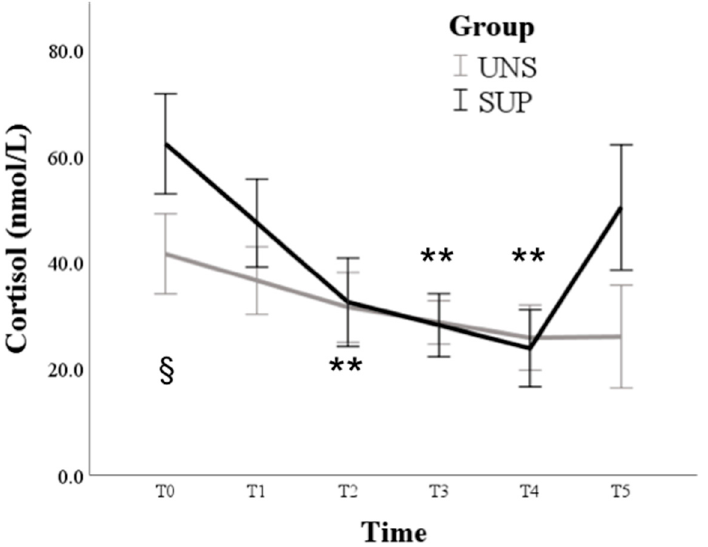
Figure 7. Means and standard errors of cortisol plasma concentrations in control (UNS) and supple- mented (SUP) lactating sheep monitored before the administration of supplementation (T0) and then every 10 days until dry off (T1–T5). § p < 0.05 UNS vs. SUP; ** p < 0.01 vs. T0 in SUP.